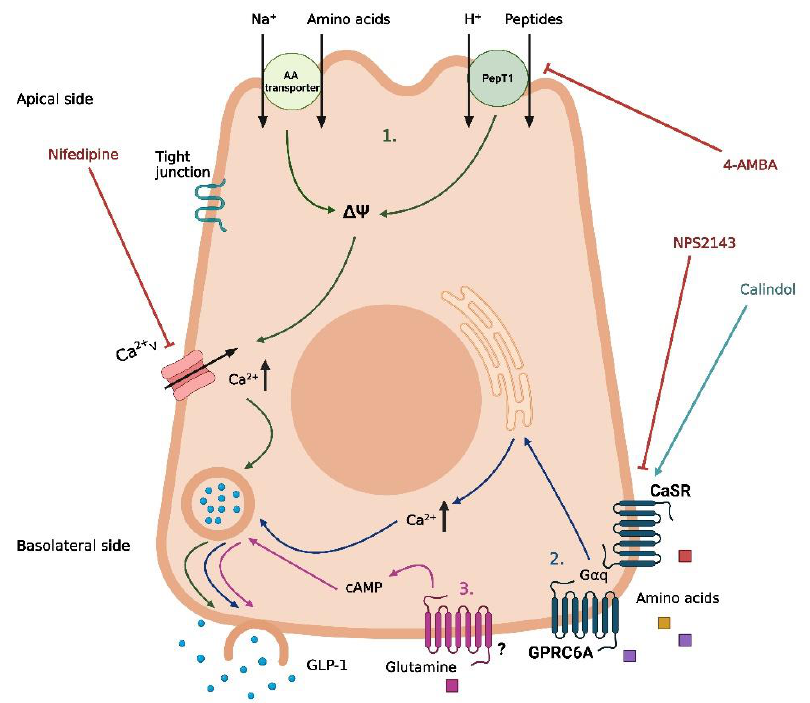
Figure 3. Proposed mechanisms of protein-induced GLP-1 secretion in intestinal L-cells. (1) Uptake of free amino acids through coupled transport with Na + and uptake of peptides/H + by PepT1, leading to depolarization and opening of voltage-gated Ca 2+ -channels. (2) Basolateral activation of CaSR and GPRC6A by free amino acids following absorption, leading to the release of intracellular deposits of Ca 2+ . (3) Basolateral activation of an unknown receptor by glutamine following absorption, leading to an increase in cAMP. Nifedipine is a Ca 2+ channel inhibitor, 4-aminomethylbenzoic acid (4-AMBA) is a PepT1 inhibitor, NPS2143 is a CaSR inhibitor, and calindol is a CaSR agonist. The graphic was created with BioRender.com.